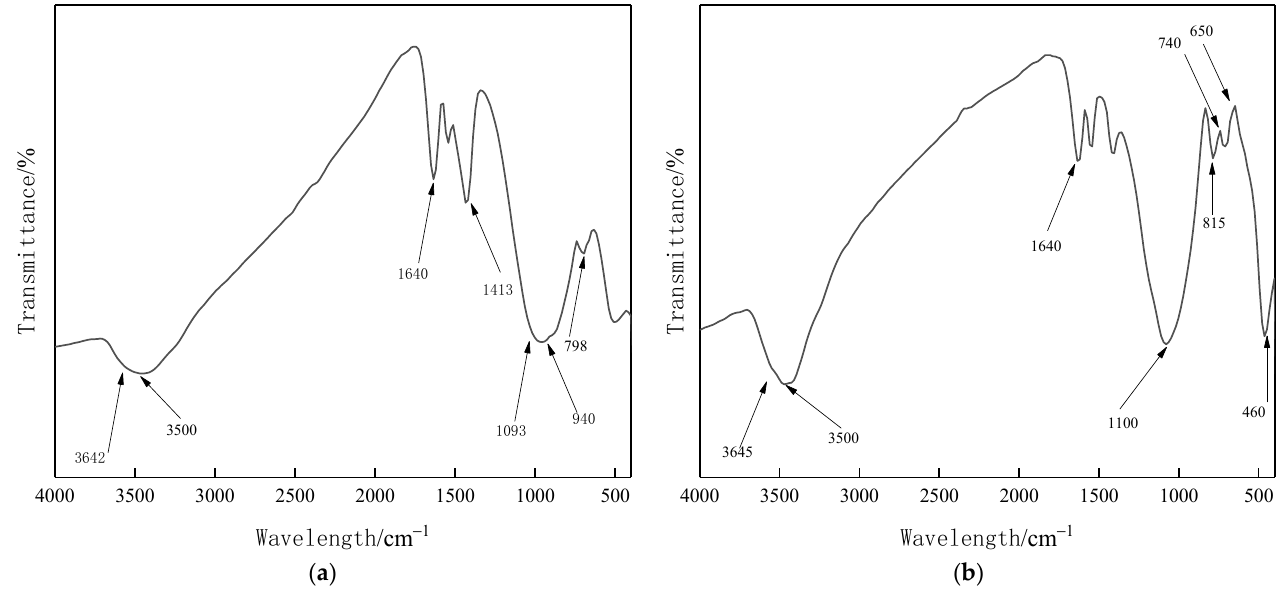
Figure 7. FTIR plots of slag and fly ash. ( a ) Slag, ( b ) Fly ash.